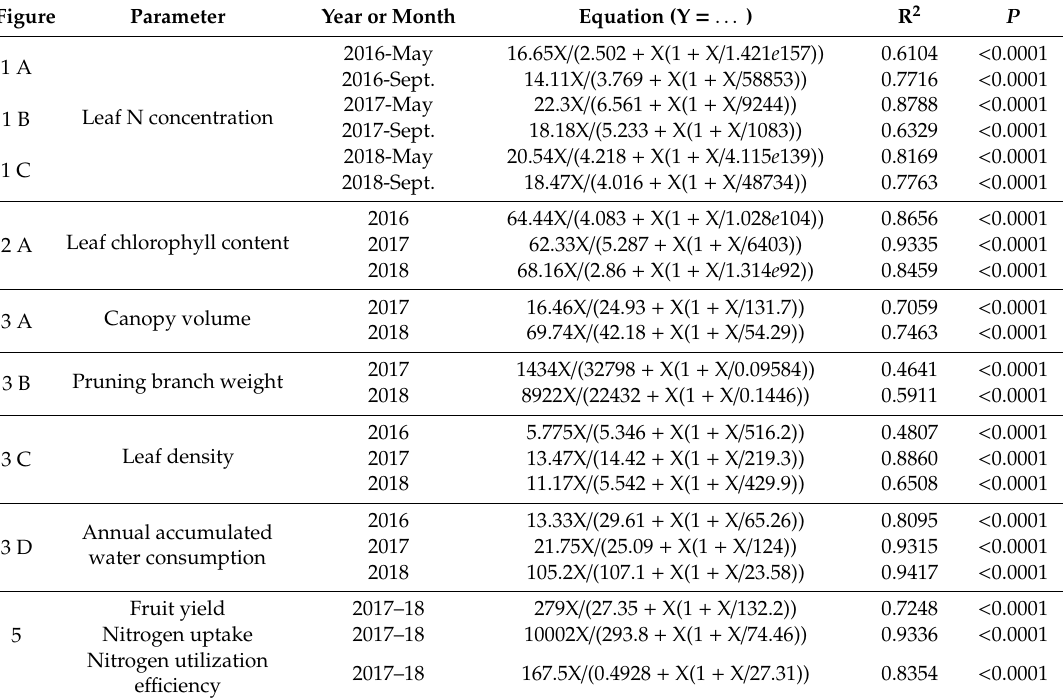
Table A1. Regression equations and statistics for Figures 1–3 and 5.